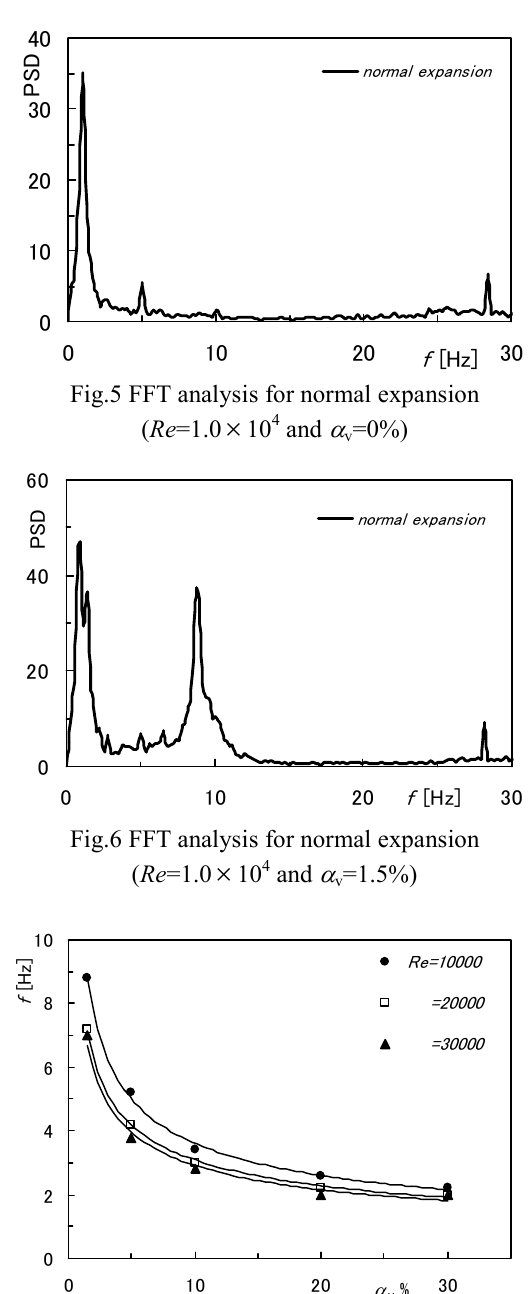
Fig.7 Second peak frequency in respect to gas